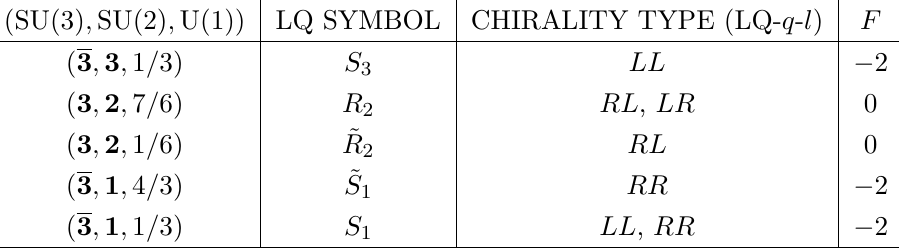
Table 1 . Scalar leptoquark multiplets, chiralities of the leptoquark interactions with the SM quark- lepton pairs, and associated leptoquark fermion